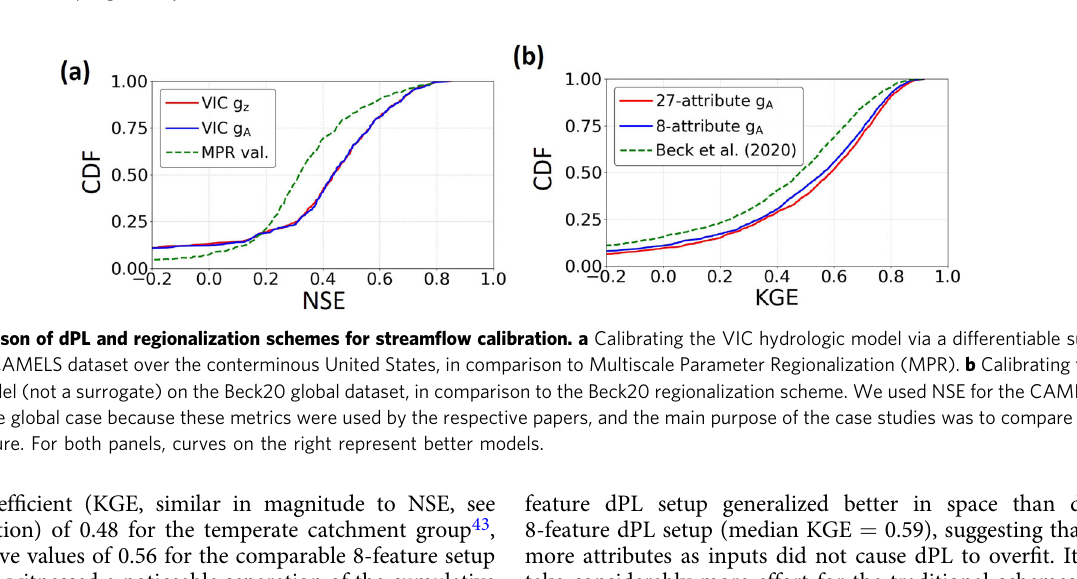
Fig. 5 Comparison of parameters generated by dPL and SCE-UA. The continuous, spatially representative patterns of a dPL-inferred parameters are noteworthy, especially in comparison to the discontinuous, random appearance of b SCE-UA-inferred parameters from site-by-site calibration. Both were trained with a 1/8 2 sampling density.